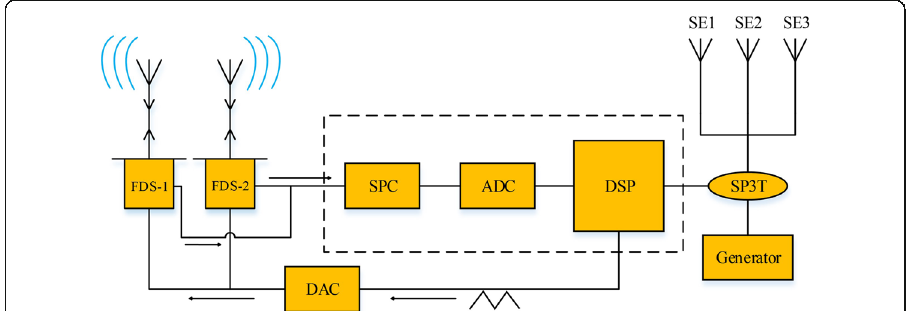
Fig. 9 Principle block diagram of the smart antenna. FDS and SPC denote the FMCW distance sensor and signal processing circuit,